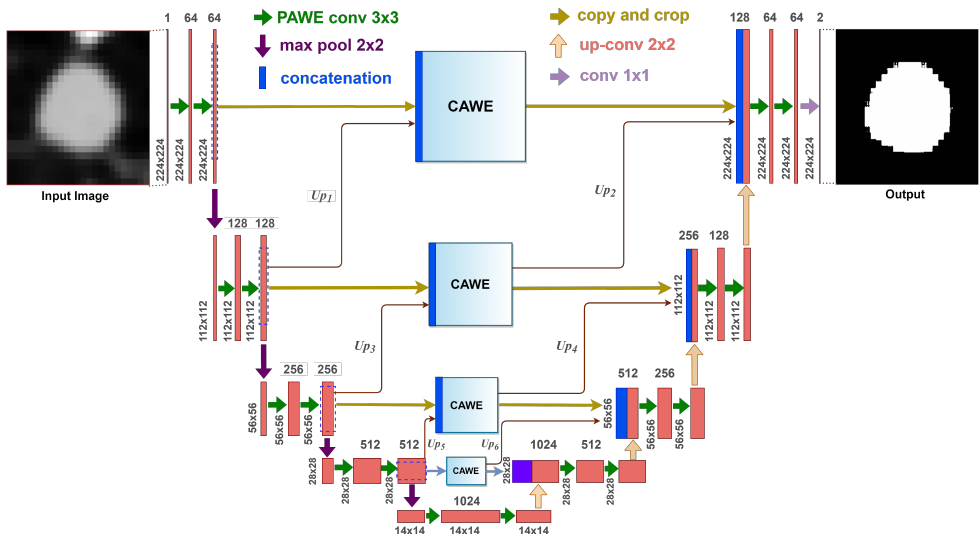
Figure 3. The architecture of the proposed AWEU-Net. The PAWE and CAWE block refers to the po- sition attention-aware weight excitation and channel attention-aware weight excitation,